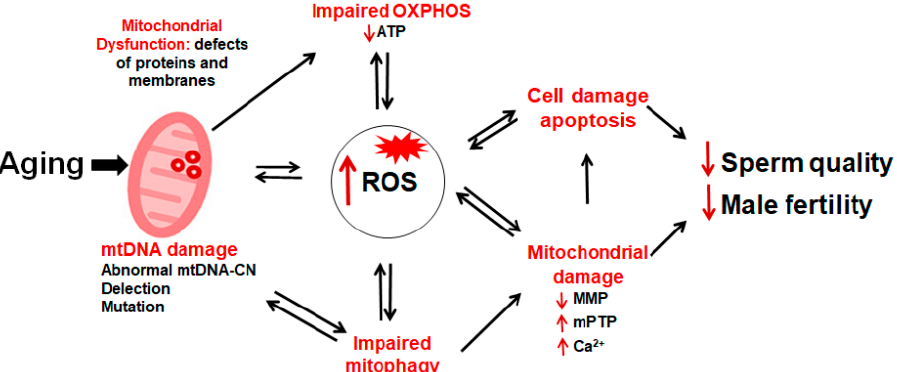
Figure 4. Schematic diagram of mitochondrial dysfunction and male infertility. Aging of the male reproductive system involves multi-factorial changes. Alterations to mitochondria are among the most remarkable features contributing to lower fertility. Abnormal mitochondrial OXPHOS leads to a decrease in ATP production, and abnormal mitophagy results in the inability to clear damaged mitochondria in time, all of which will lead to an increase in ROS. Excessive ROS in turn will further affect mitochondrial function, and eventually fall into a “vicious circle”, leading to mitochondrial damage and cell apoptosis, affecting sperm quality and fertilization potential, and ultimately contributing to male infertility.